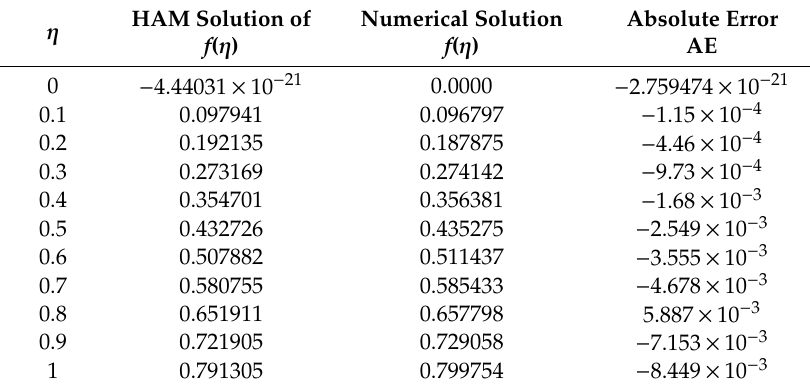
Table 3. Relationship between Homotopy Analysis Method (HAM) and Numerical techniques for f ( η ) in case of n = 1, when β = ε = 1, St = M = 0.1, ξ = 0.8.